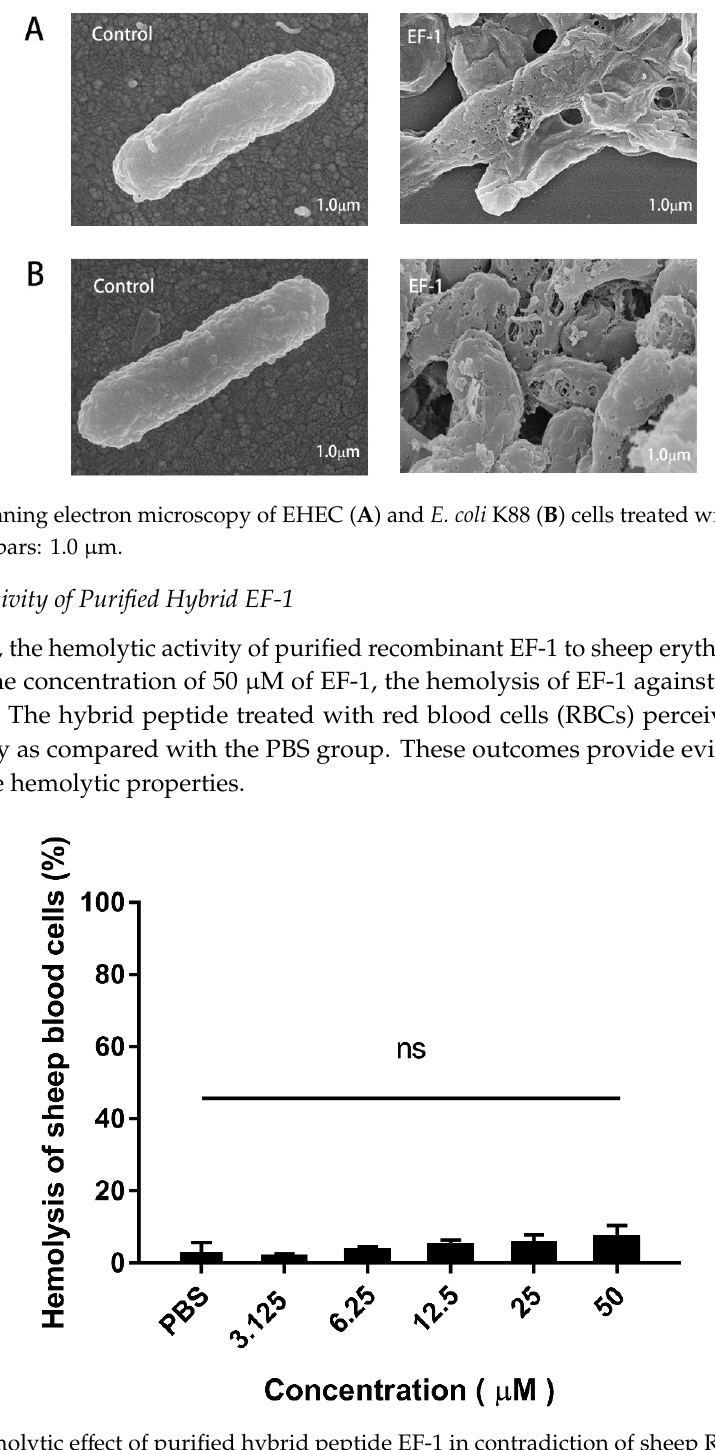
Figure 4. Propidium iodide uptake by enterohemorrhagic EHEC ( A ) and E. coli K88 ( B ) in the presence of purified recombinant EF-1, 0.05% ( w / v ) SDS the maximum fluorescence, BSA as a negative control. ( A ) 1, and 4 × MIC of purified EF-1 against E. coli K88 were the concentration of 1.5, 3.125, and 6.25 μM.